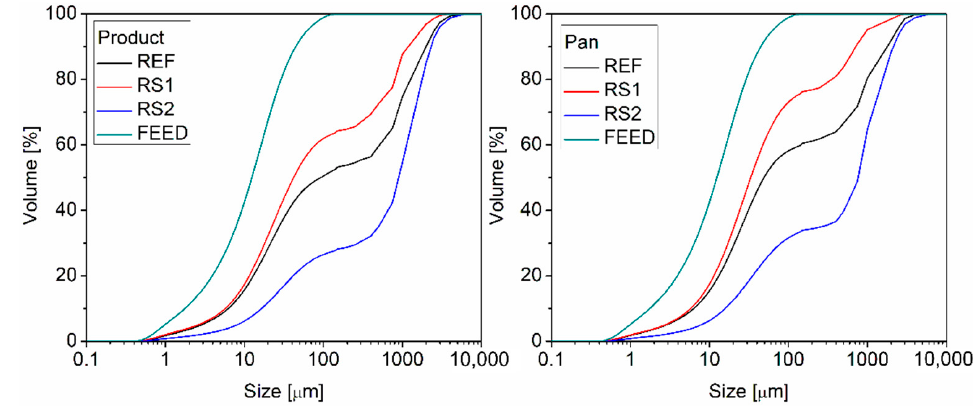
Figure 10. Influence of the RS of the pan on PSD of product samples of pan granulation.